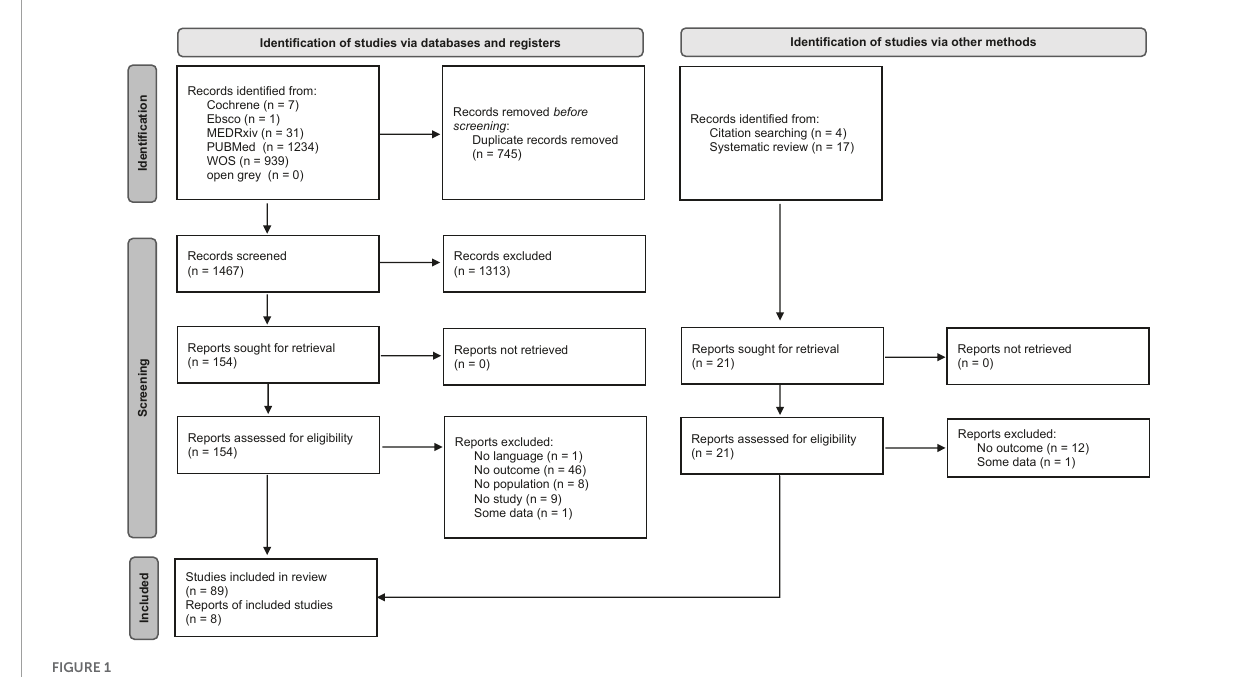
FIGURE1 PRISMA flow diagram showing the process of study